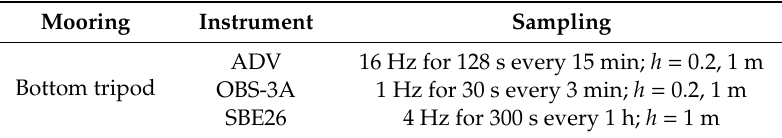
Figure 1. Map of the study area. The black star denotes the location of the anchor station, the arrows denote the flood and ebb directions of the rectilinear tidal currents, and the positive direction is 10° anticlockwise from the north (ebb direction). Unfortunately, the update data are insufficient to identify depth contour lines in the study area. Table 1. Deployment scheme of the measurements ( h is the height of the instrument sensor above seabed (asb), the deployment period is 25 h for continuous observation).